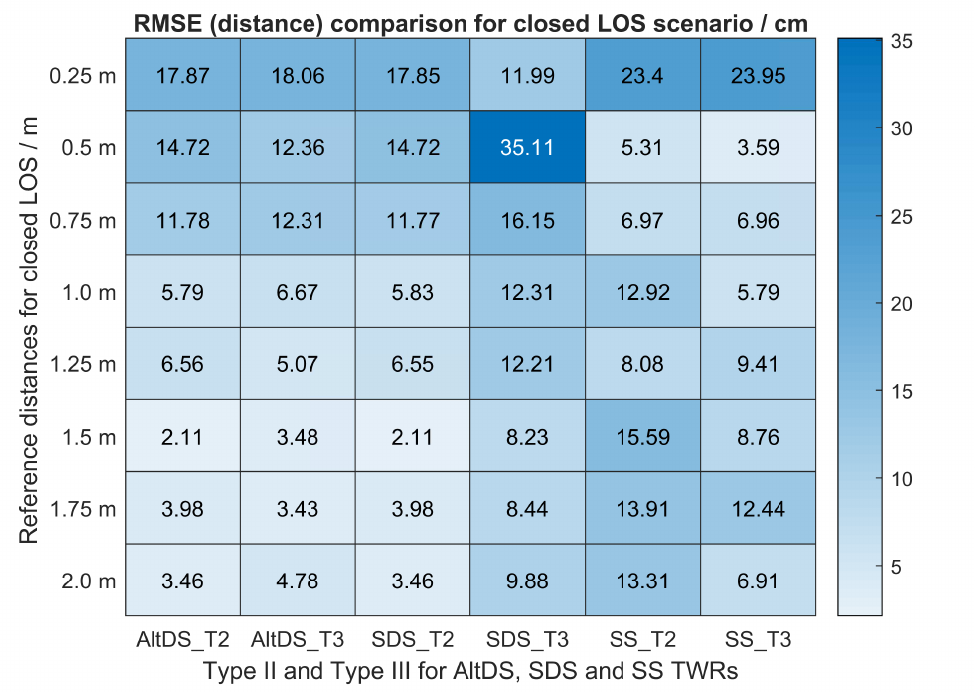
Figure 11. Results comparison of Types II and III for close LOS at true reference 0.25, 1.00, and 1.50m. ( a – c ) measurement results for Type II (special case), and ( d – f ) corresponding results for Type III (typical case).